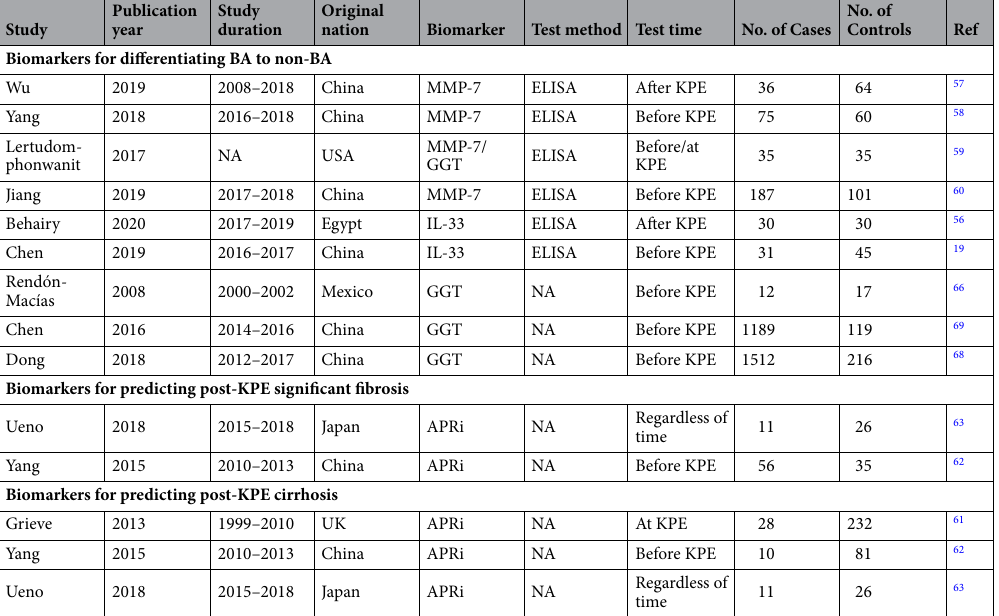
Table 1. Characteristics of included studies in the “study-level” analysis. Abbreviations: BA, biliary atresia; MMP-7, matrix metallopeptidase-7; IL-33, interleukin 33; GGT, γ-glutamyl transferase; APRi, aspartate aminotransferase to platelet ratio index; post-KPE, after Kasai portoenterostomy; ELISA, enzyme-linked immunosorbent assay; CLEIA, chemiluminescent enzyme